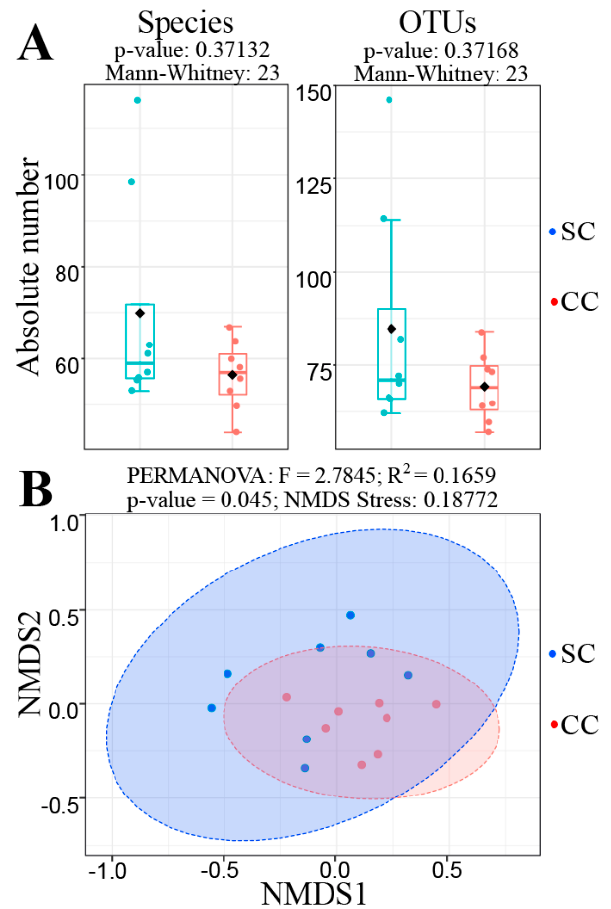
Figure 2. Alpha and Beta diversity analyses comparing the mycobiota of SC and CC animals. Panel ( A ) shows the result of an alpha diversity analysis, displaying the absolute number of fungi obtained for the levels of species (left) and operational taxonomic units (OTU) (right), in both SC and CC animals. In both cases, it was not possible to verify significant changes in fungal alpha diversity between the two groups, since p -values obtained from such analyses, after a Mann–Whitney U test, were always above 0.05. Panel ( B ) shows the result of a Beta-diversity analysis to evaluate differences in composition between the fungal populations present in the stool samples from SC and CC animals. This analysis was performed with the aid of a non-metric multidimensional scaling (NMDS) algorithm (based on the Bray–Curtis index), using the same OTU Table described above. The NMDS analysis shows that differences in mycobiota composition allow statistically significant discrimination between the SC and CC groups (at p = 0.045, as verified by PERMANOVA), although the two main components of the NMDS analysis do not allow us to visualize such distinction. Animals from the SC group are shown in blue, while animals from the CC group are shown in red.